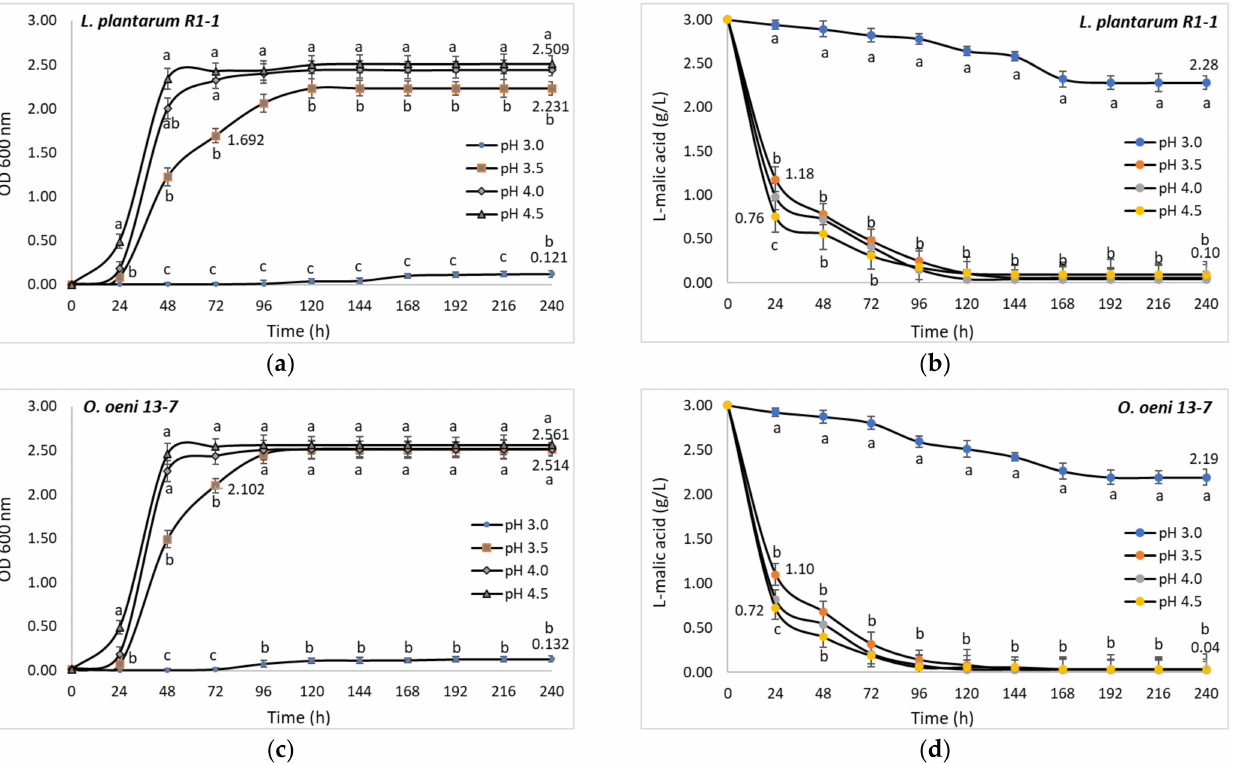
Figure 7. Influence of pH on cell development and malic acid metabolism of Lactobacillus plantarum strain R1-1 ( a,b ) and Oenococcus oeni strain 13-7 ( c , d ). Cells incubated in MRS-TJ broth (10 6 CFU/mL) at 28 ◦ C. Each value is the mean of a triplicate experiment; error bars indicate standard deviation ( ± ). In all cases the standard deviation was lower than 10% of the mean value. Different letters within the same column indicate significant differences between data ( p <